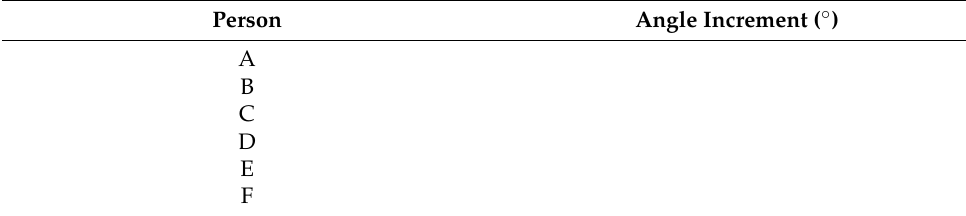
Table 12. Data recording for angle increment.